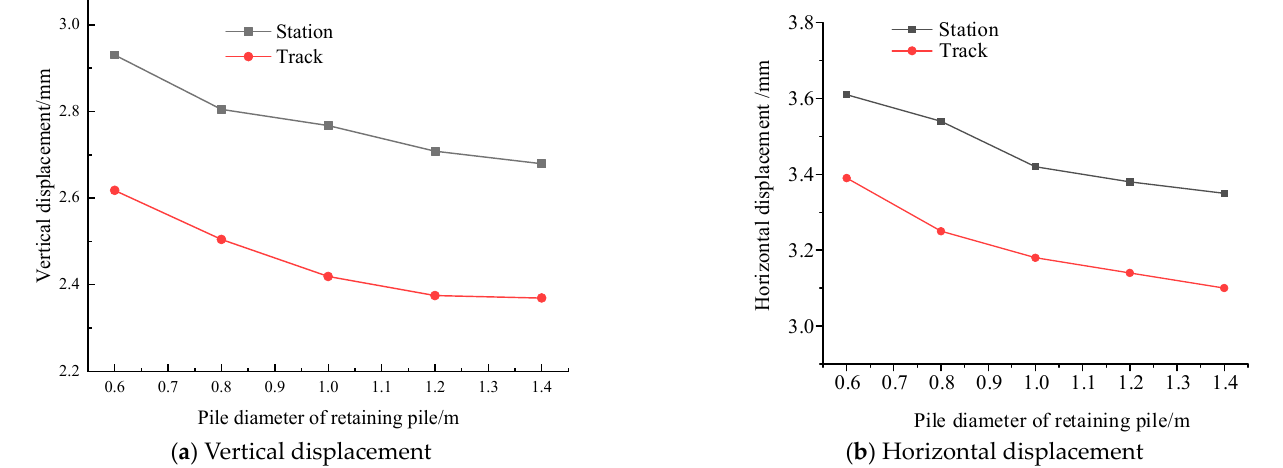
Figure 26. Maximum vertical and horizontal displacements of stations and track structures under different pile diameters.